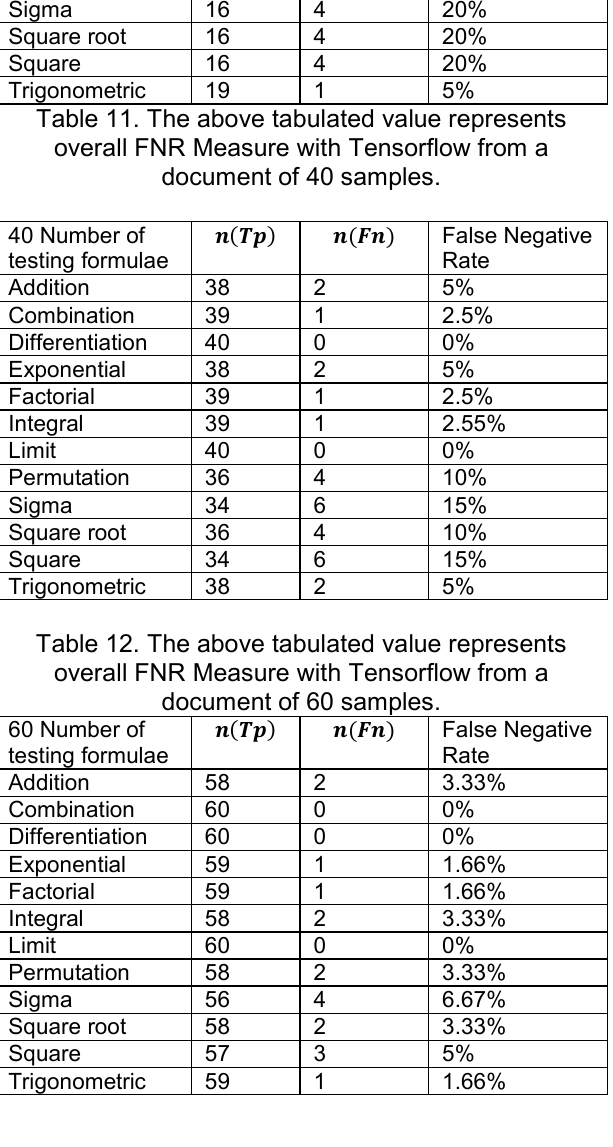
Table 13 . The above tabulated value represents overall FPR Measure with Tensorflow from a document of 20 samples.